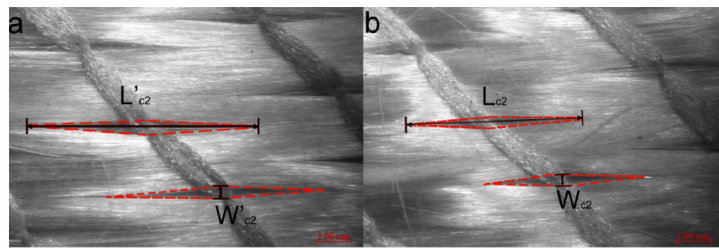
Figure 6. In-plane microstructure of ± 45 ◦ fiber piles of quasi-axial non-crimp fabric in ( a ) uncompressed state and ( b ) compressed in vacuum